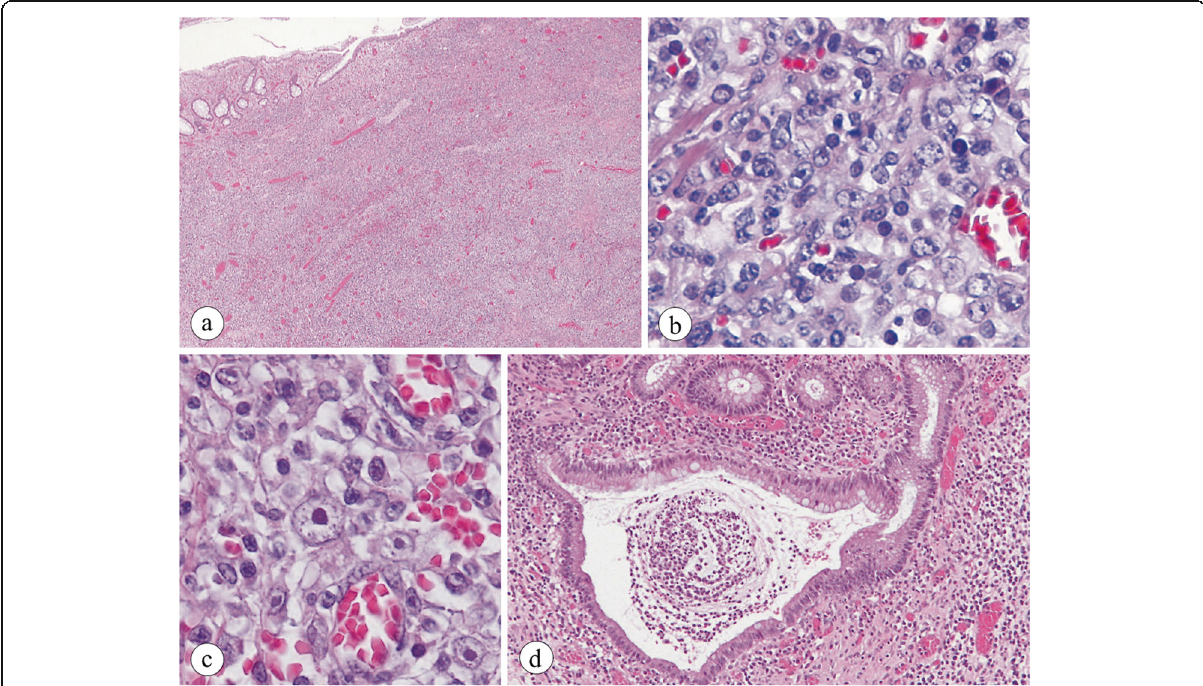
Fig. 2 Histological findings of the resected colon: a The resected colon is transmurally infiltrated by lymphoid cells, and the existing structure is indistinct. b Atypical polymorphous cells diffusely proliferate. c A few Hodgkin-like cells with an eosinophilic nucleolus in the center of a large nucleus are present. d A crypt abscess surrounded by mixed inflammatory cell infiltrates is present in the lamina propria mucosae remote from the lymphoma, compatible with the findings of UC